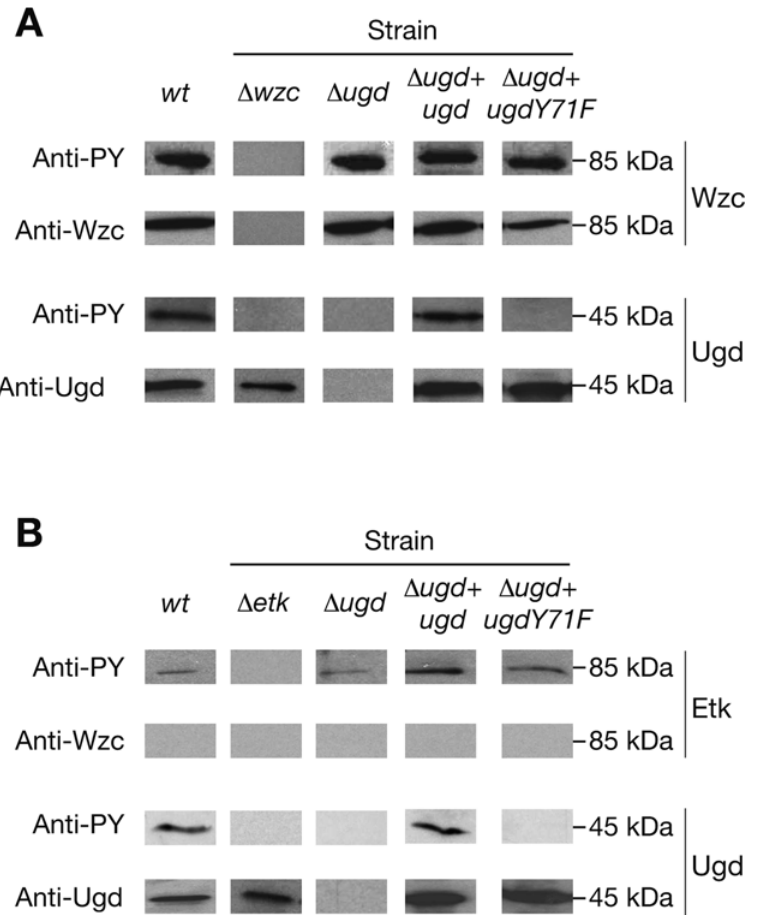
Figure 1. Expression and invivo phosphorylation of Ugd, UgdY71F and Wzc or Etk. Western immunoblot of whole-cell lysates prepared when E. coli is grown under conditions allowing (A) colanic acid production or (B) polymyxin resistance were probed with either a Wzc-specific monoclonal antibody (Anti-Wzc), or a Ugd-specific monoclonal antibody (Anti-Ugd), or an anti-phosphotyrosine antibody (Anti-PY). E. coli wild-type strain ( wt ), wzc - or etk -deficient strain ( D wzc or D etk ), ugd -deficient strain ( D ugd ) and ugd -deficient strain complemented with wild-type ugd ( D ugd + ugd ) or mutated ugd ( D ugd + ugdY71F ).